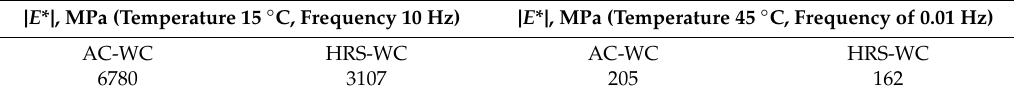
Figure 9. Effect of temperature and frequency on the phase angle of HRS-WC mixture.